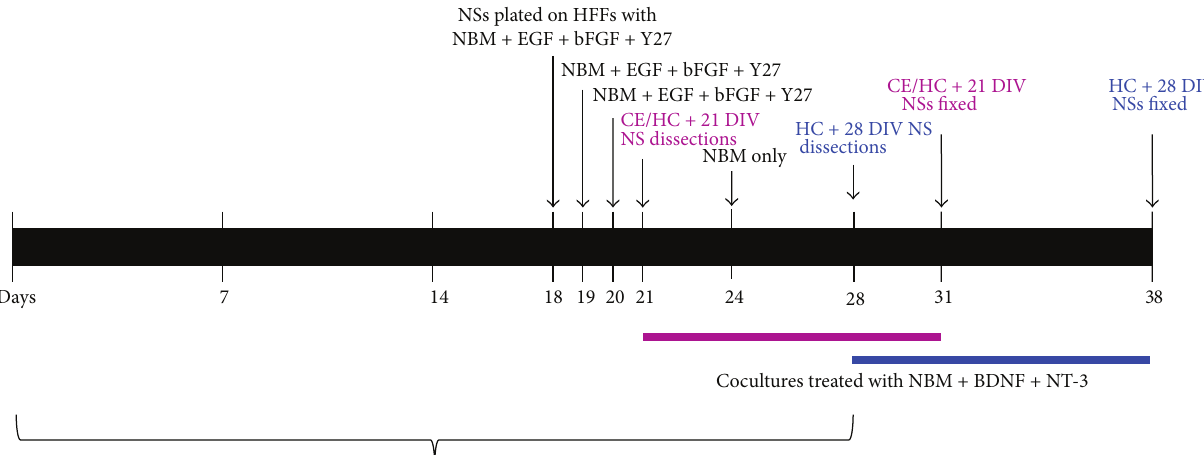
Figure 1: Timeline for coculture experiments. The stem cell lines were differentiated towards a neuronal lineage for either 21 or 28 days in vitro (DIV). For the cochlear explant cocultures, 21 DIV neurospheres were cocultured with cochlear explants for up to 10 days (red). For the synapse forming assay experiments, 21 (red) and 28 (blue) DIV neurospheres were cocultured with hair cells for 10 days in each case. The cocultures were treated with NBM, BDNF, and NT-3. DIV: days in vitro ; NBM: neurobasal media; EGF: epidermal growth factor; bFGF: basic fibroblast growth factor; HFF: human foreskin fibroblasts; CE: cochlear explant; HC: hair cell; NS: neurosphere; and Y27: small molecule